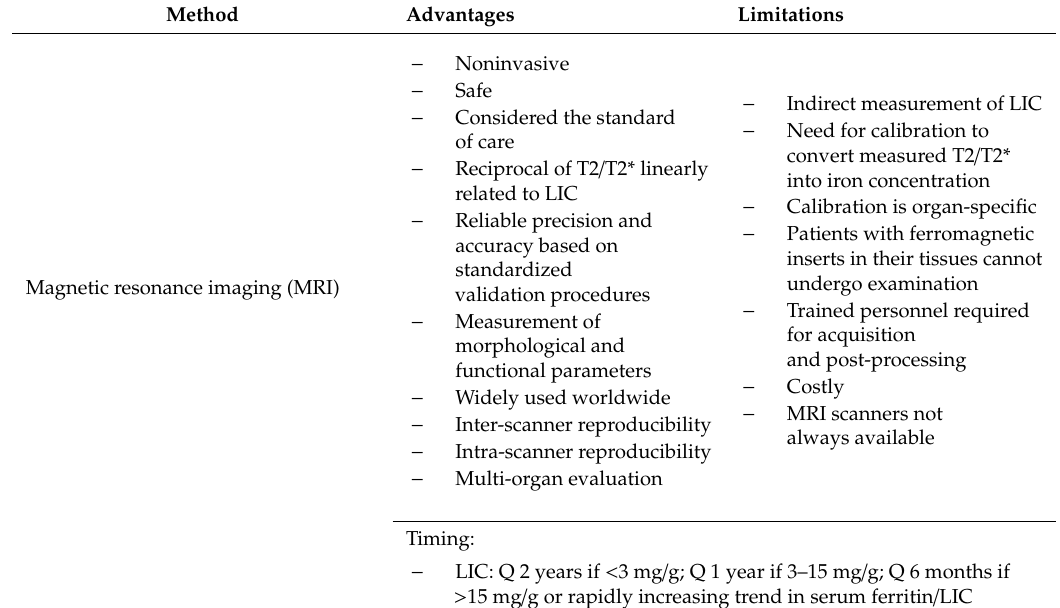
Table 5. Quantification of iron overload: methods